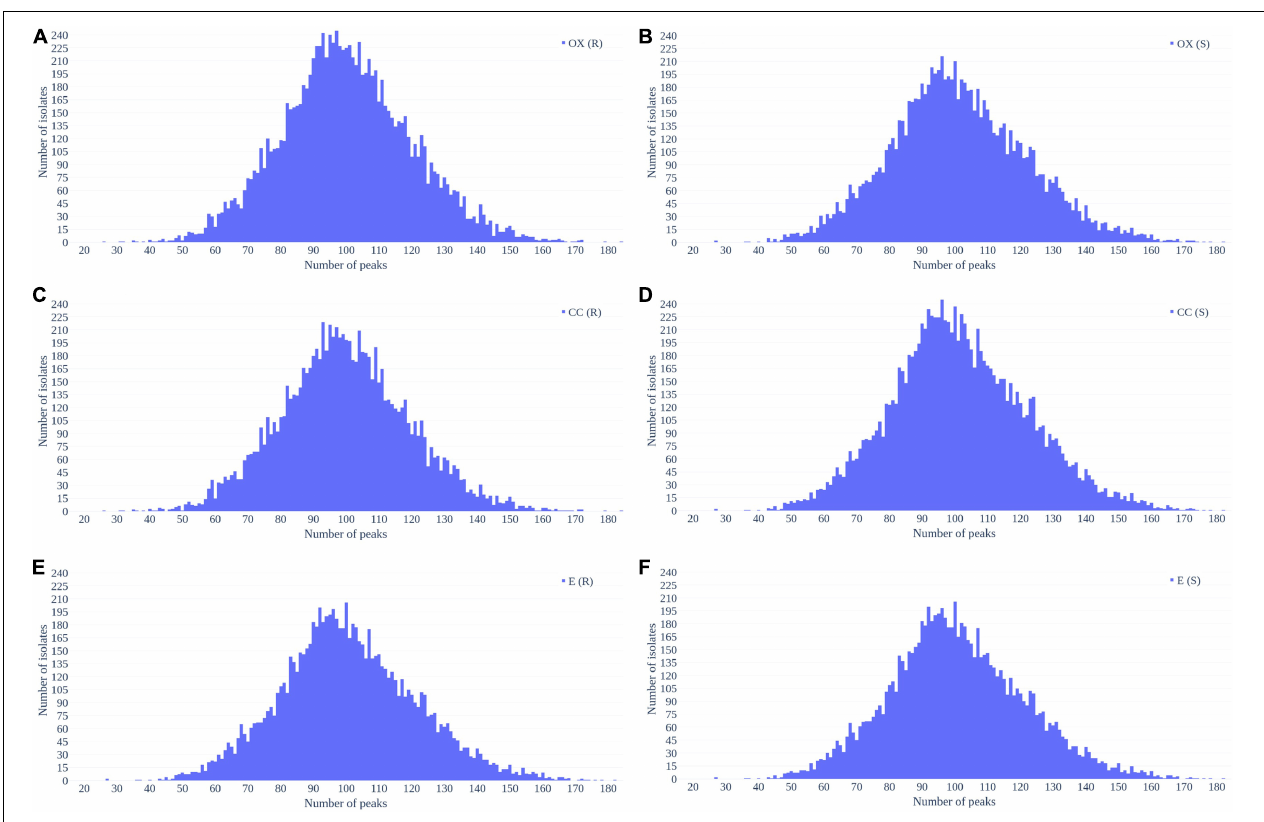
FIGURE 2 | Distribution of number of peaks retrieved from each spectrum in (A) oxacillin-resistant, (B) oxacillin-susceptible, (C) clindamycin-resistant, (D) clindamycin-susceptible, (E) erythromycin-resistant, and (F) erythromycin-susceptible Staphylococcus aureus